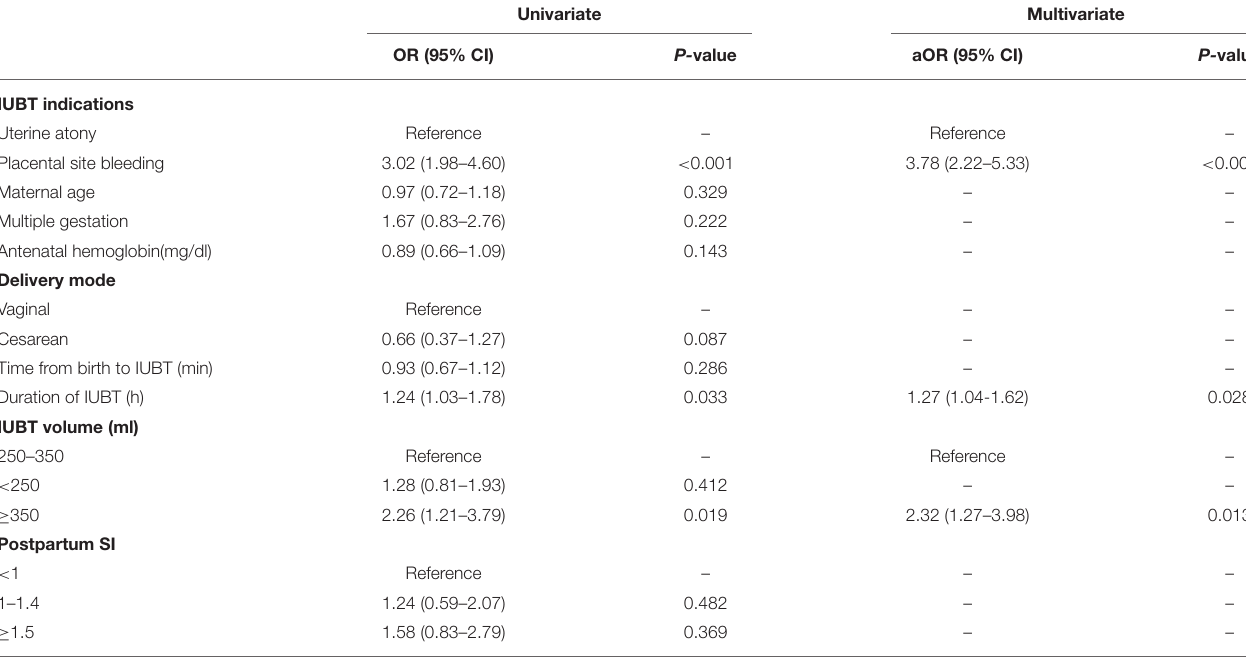
TABLE 4 | Risk factors for the prevalence of EBL ≥ 300ml after